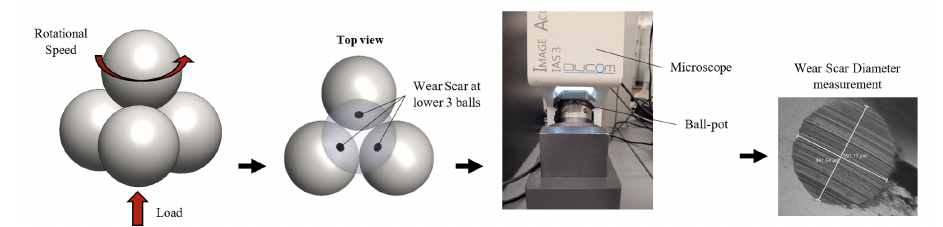
Figure 4. Wear scar diameter (WSD) measurement after each test. The special-purpose microscope allows for the measurement of the WSD on the lower three balls without removing the balls from the ball pot. Each reported WSD is the average of the WSD measurements on the lower three balls.